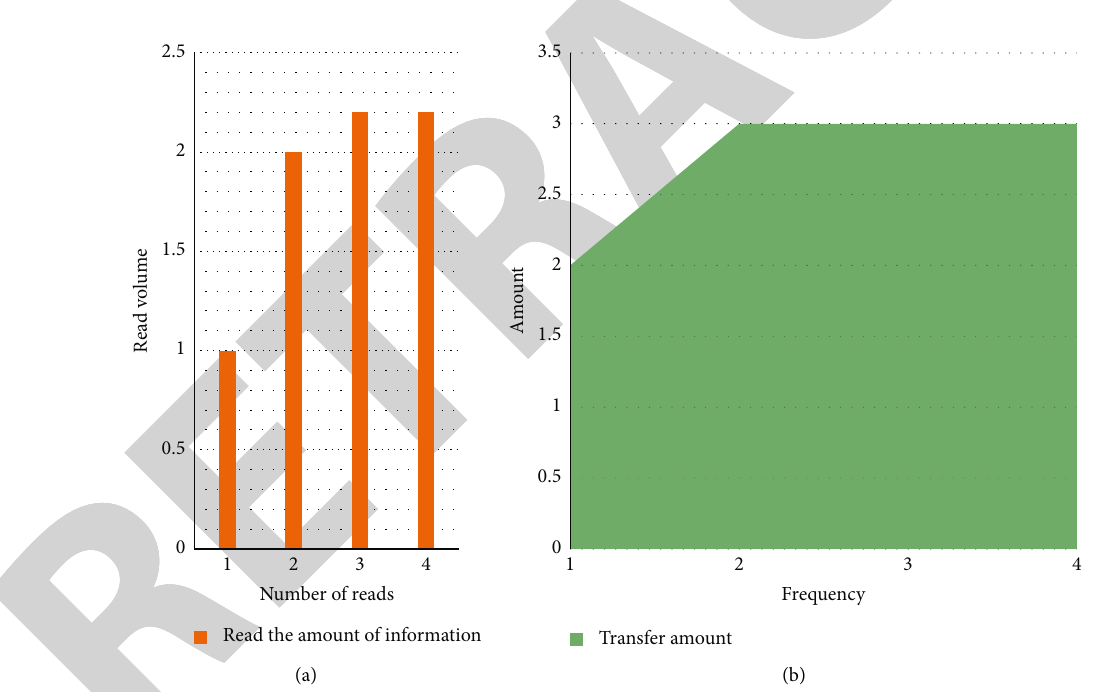
Figure 5: The relationship between account security and password length in system